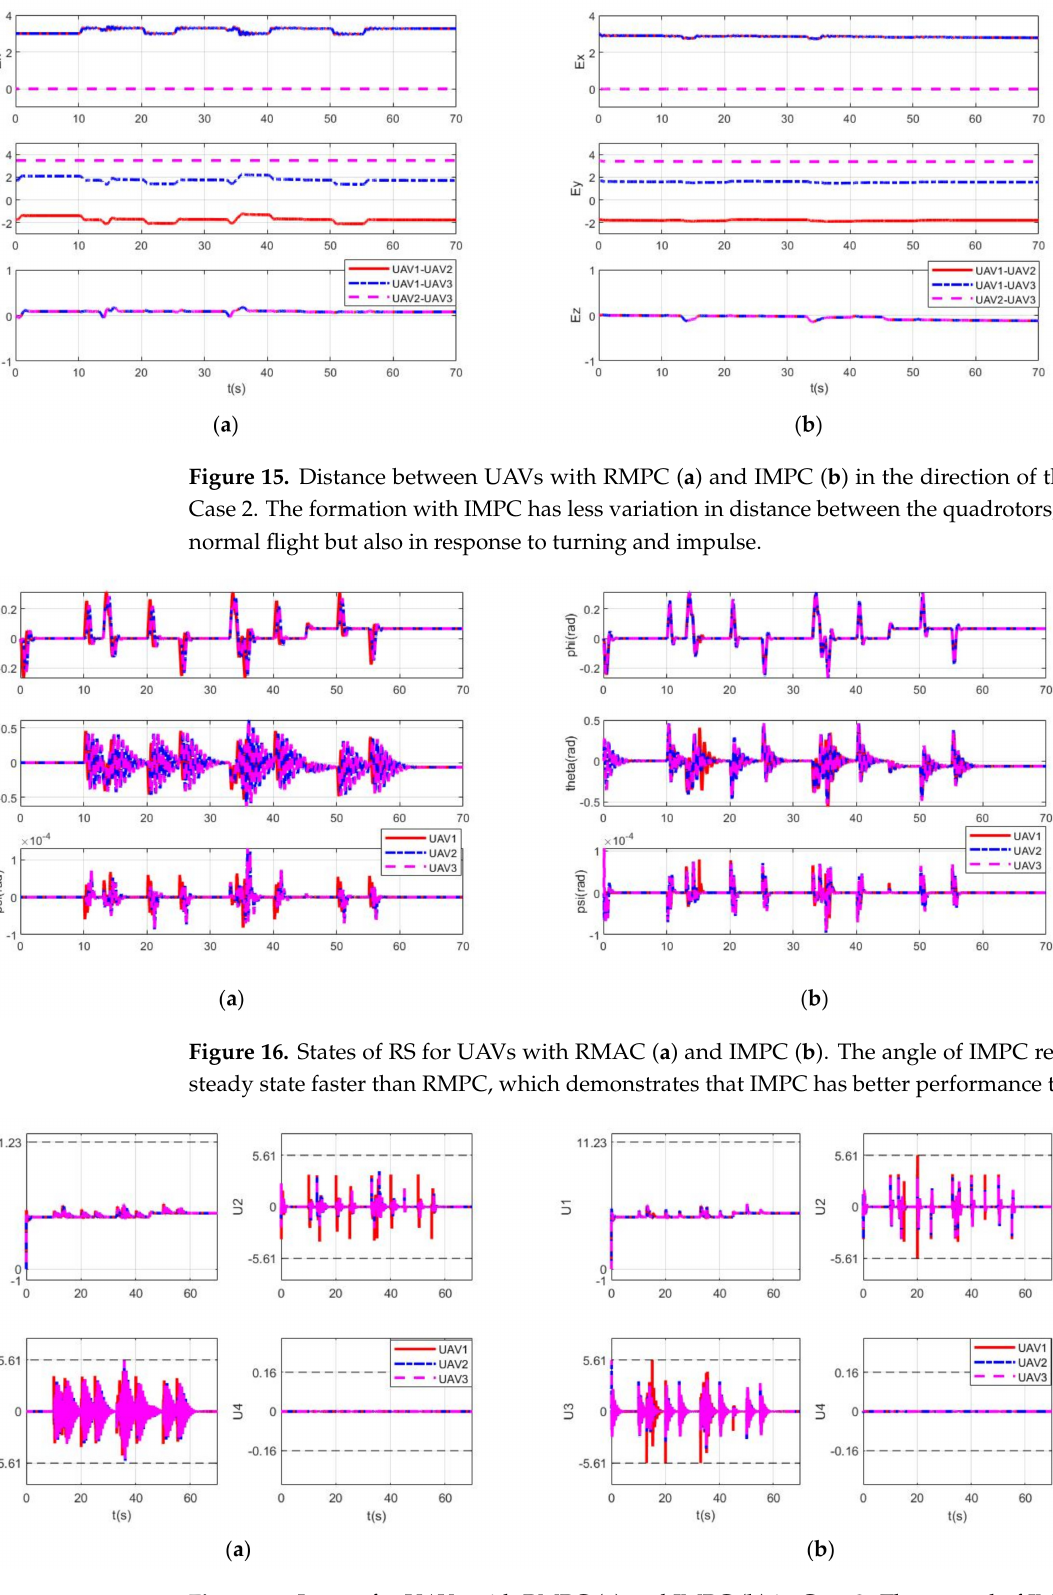
Figure 17. Inputs for UAVs with RMPC ( a ) and IMPC ( b ) in Case 2. The control of IMPC has less oscillation in response to turns and impulses and can return to the steady state faster. This indicates that IMPC has better dynamic performance than